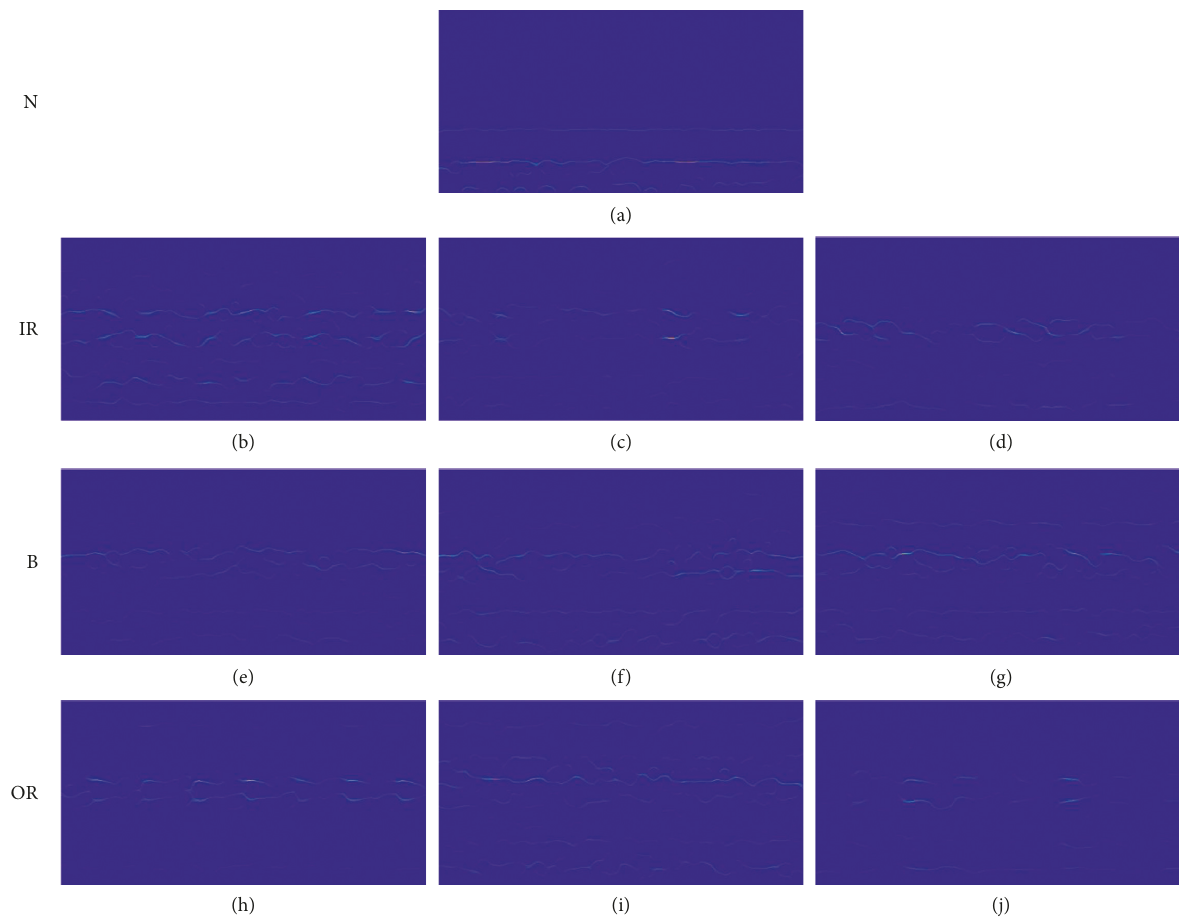
Figure 8: MSSTof vibration signals in Figure 7: (a) N, (b) IR7, (c) IR14, (d) IR21, (e) B7, (f) B14, (g) B21, (h) OR7, (i) OR14, and (j)